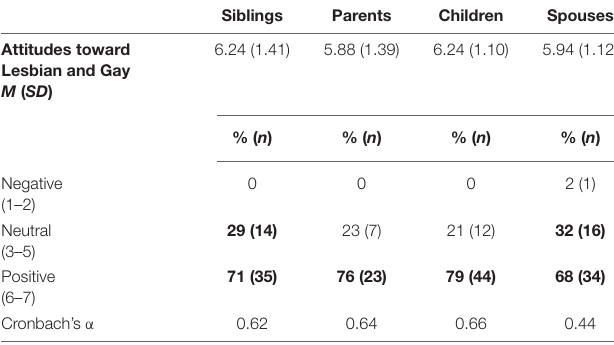
TABLE 9 | Attitudes toward lesbians and gay men. Siblings Parents Children Spouses Attitudes toward Lesbian and